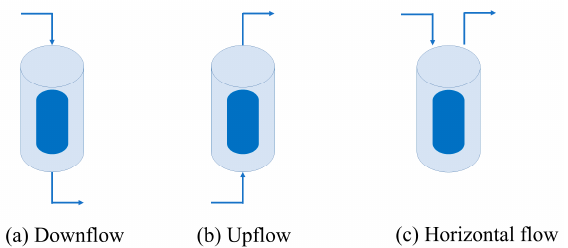
Figure 6. Different flow systems used in supercritical drying experiments. ( a ) Downflow; ( b ) upflow; ( c ) horizontal. Arrow directions show entrance of pure CO 2 and exit of the effluent stream consisting of CO 2 and the solvent whereas the dark blue cylinder represents the gel placed inside the vessel.